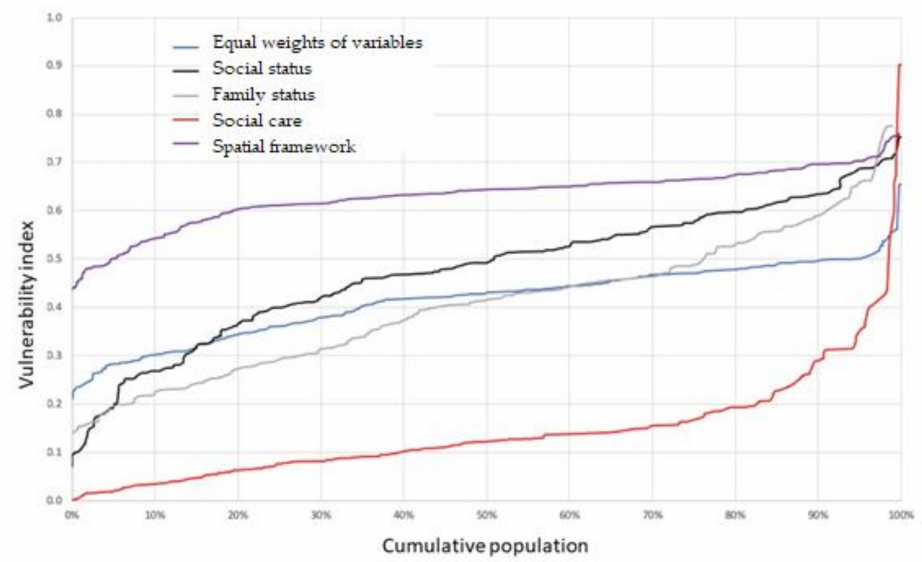
Figure 10. Pen’s Parade curve of the vulnerability index for the population, by category. Source: